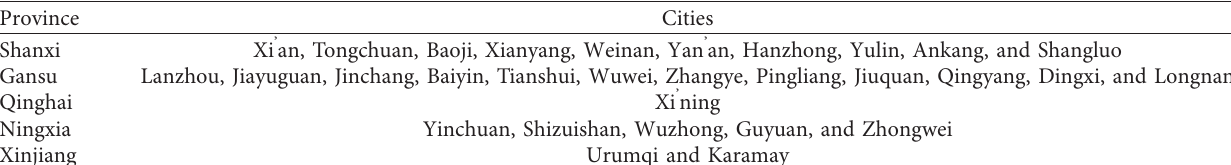
Table 1: Data source cities.